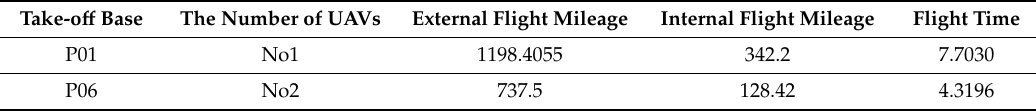
Table 6. The cooperative strategy of UAVs for